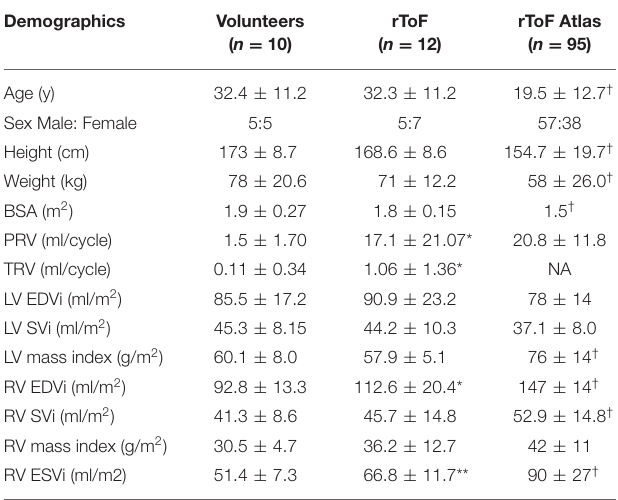
TABLE 1 | Demographics and cardiac parameters (mean ±